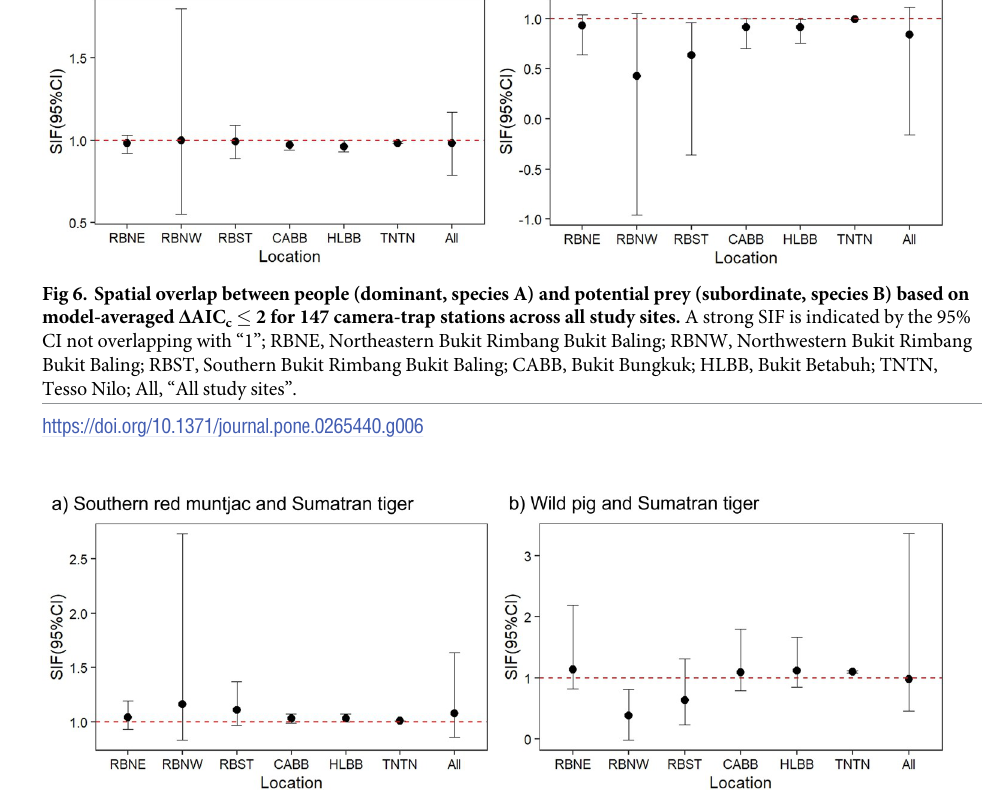
Fig 7. Spatial overlap between potential prey species (dominant, species A) and Sumatran tigers (subordinate, species B) based on model-averaged Δ AICc � 2 for 147 camera-trap stations across all study sites. A strong SIF is indicated by 95% CI not overlapping with “1”; RBNE, Northeastern Bukit Rimbang Bukit Baling; RBNW, Northwestern Bukit Rimbang Bukit Baling; RBST, Southern Bukit Rimbang Bukit Baling; CABB, Bukit Bungkuk; HLBB, Bukit Betabuh; TNTN, Tesso Nilo; All, “All study sites”.